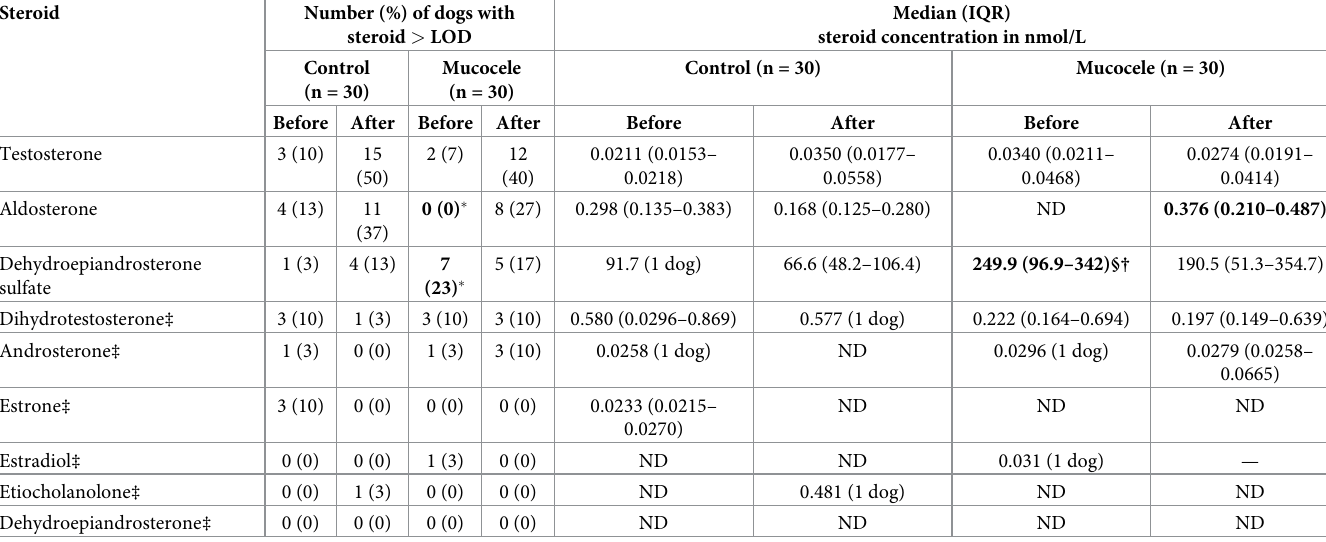
Table 2. Serum concentrations (in nmol/L) of 9 steroid hormones measured at concentrations > LOD in less than 50% of dogs before and 1 hour after intravenous administration of synthetic cosyntropin. Steroid Number (%) of dogs with Median (IQR) steroid > LOD steroid concentration in nmol/L Control Mucocele Control (n = 30) Mucocele (n = 30) (n = 30) (n = 30) Before After Before After Before After Before